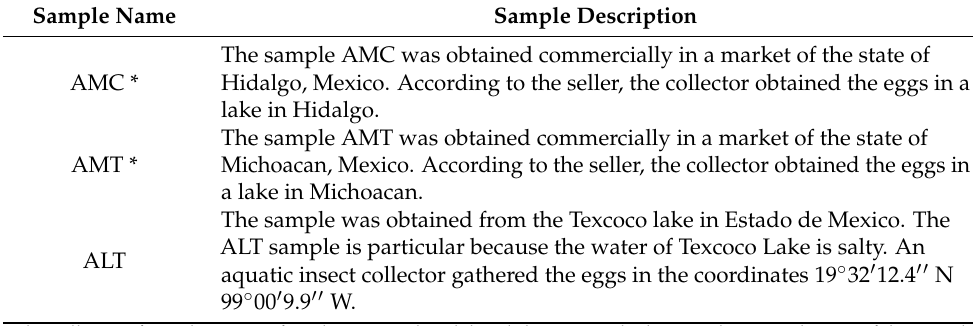
Table 1. Locations of samples of Corixidae